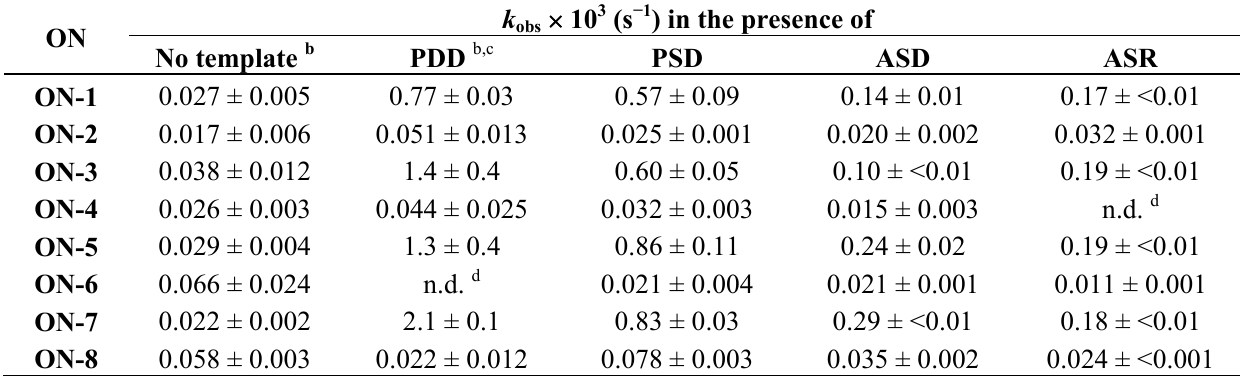
Table 2. Observed pseudo first-order rate constants of each oligonucleotide at pH 4.0, 40 °C a .